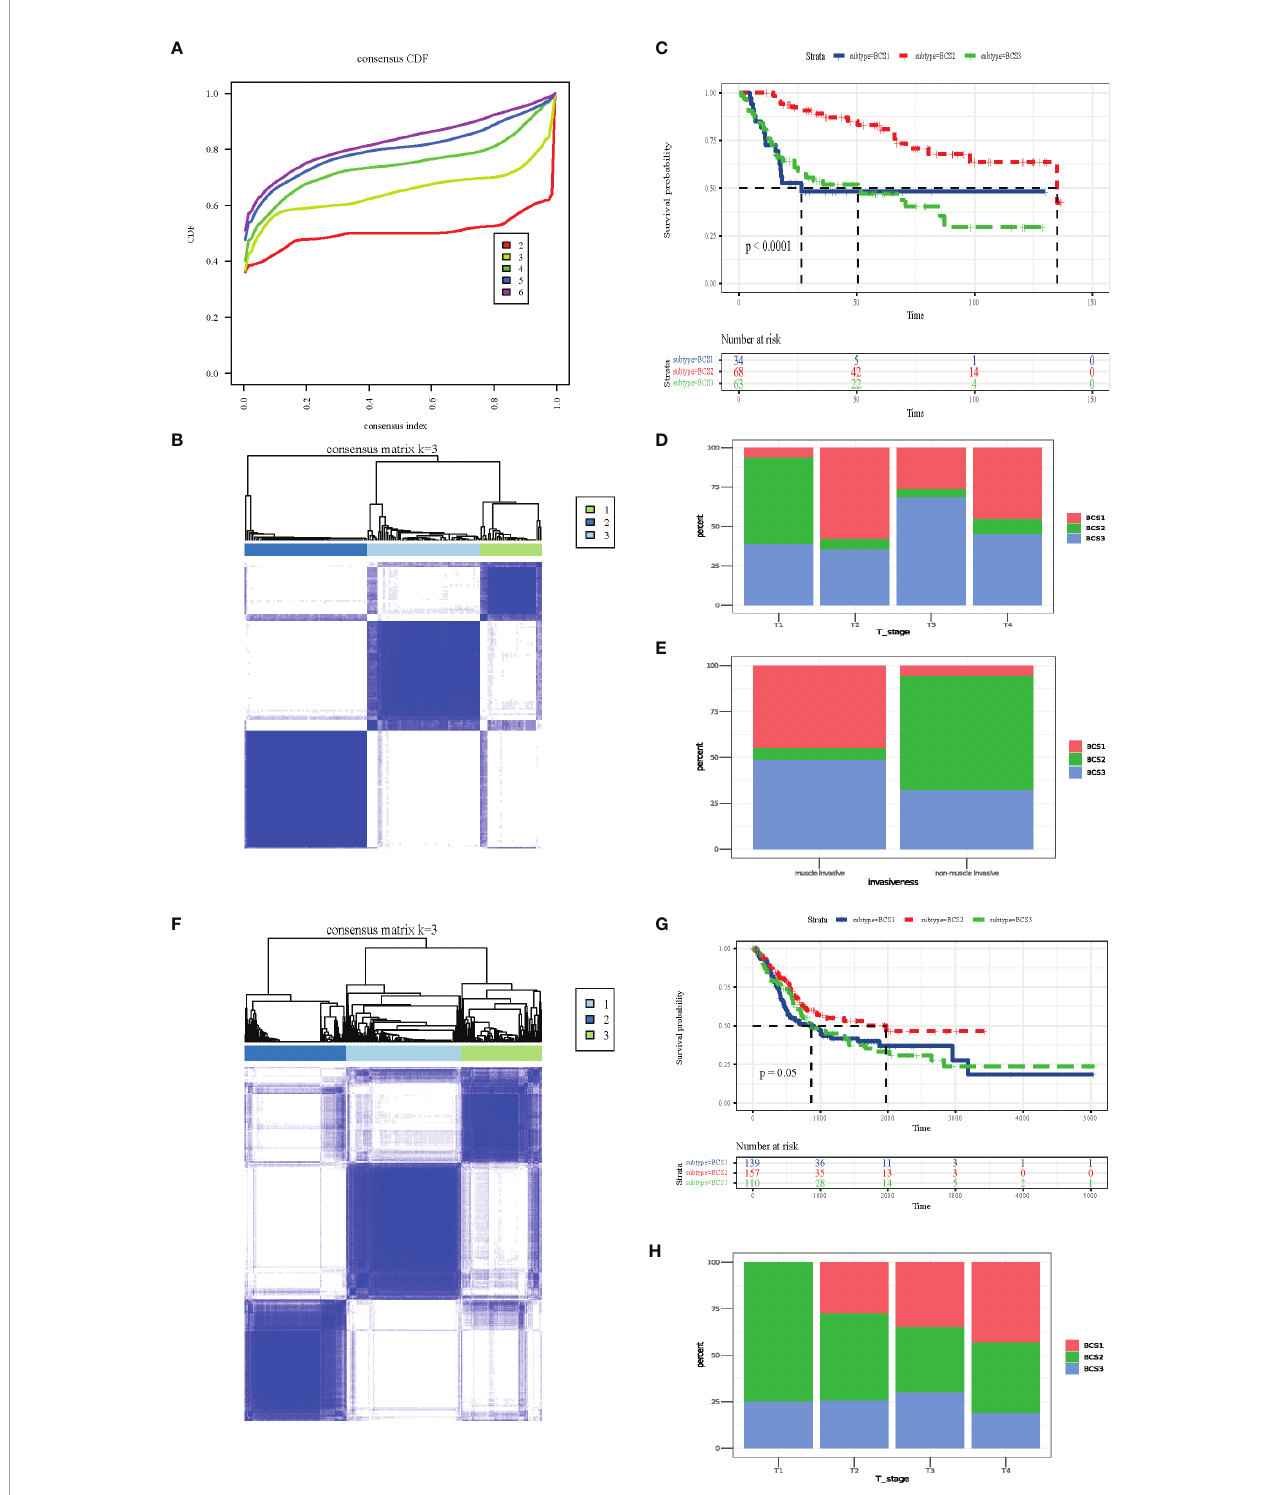
FIGURE 4 | Identi fi cation and validation of novel immune subtypes of BLCA. (A) Cumulative distribution function curve of immune-related genes in the GEO cohort. (B) Sample clustering heat map in the GEO cohort. (C) Kaplan-Meier curves showing OS of BLCA immune subtypes in the GEO cohort. (D, E) Distribution of BCS1- BCS3 across BLCA (D) T-stage and (E) invasiveness in the GEO cohort. (F) Sample clustering heat map in the TCGA cohort. (G) Kaplan-Meier curves showing OS of the BLCA immune subtypes in the TCGA cohort. (H) Distribution of BCS1-BCS3 across BLCA T-stage in the TCGA